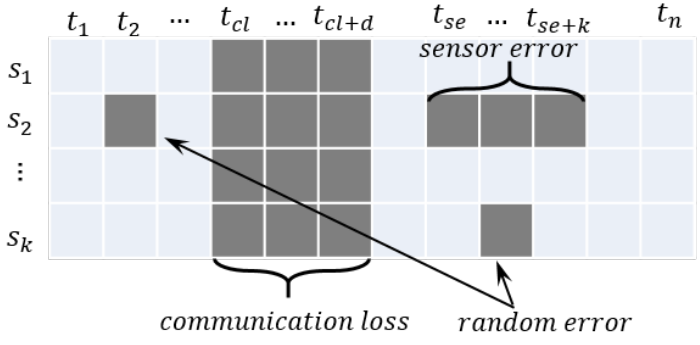
Figure 10. Examples of missing values cases in the